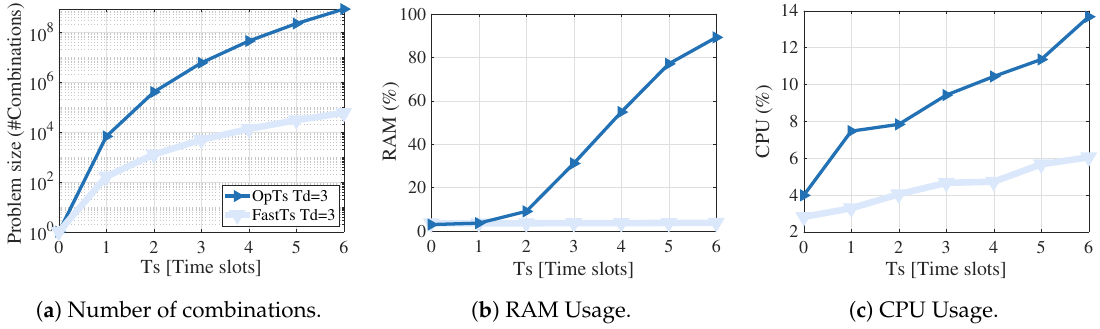
Figure 16. Combinations processed and computational resources used to execute O PT T S and F AST T S within the scope of simulation. Parameters: According to the Case B in Table 5, with numPart = 2 for F AST T S